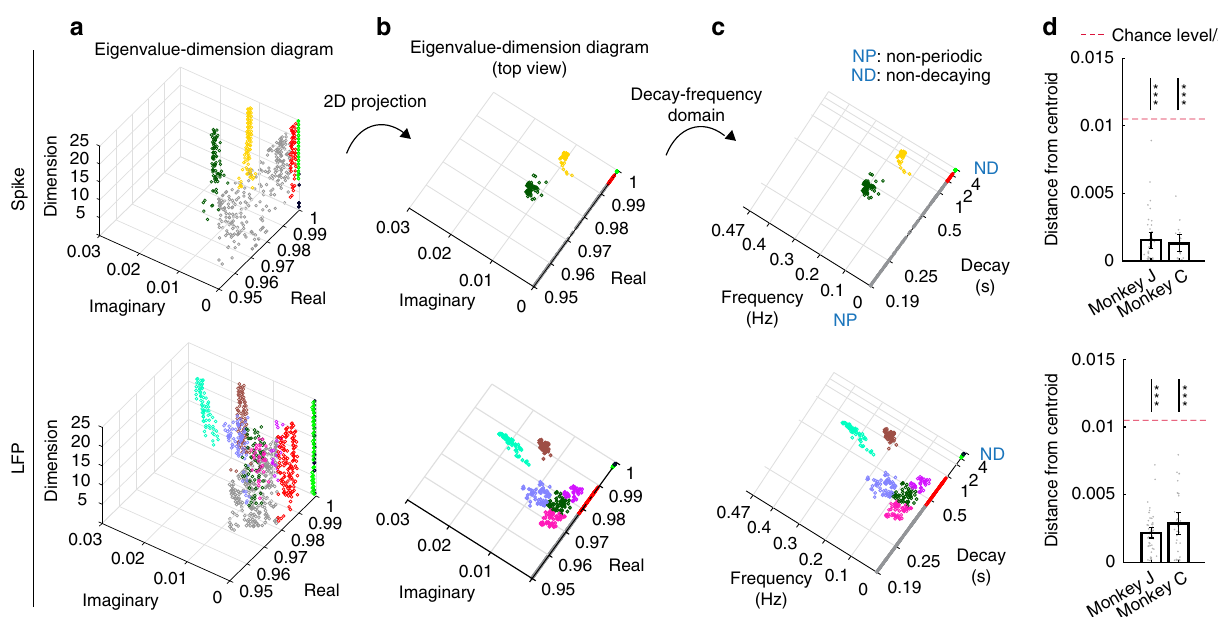
Fig. 3 Both spiking and LFP network activity exhibit several principal modes in their dynamics. a Eigenvalue-dimension diagram for spiking (top) and LFP (bottom) network activity in one sample session. The vertical clusters are principal modes each shown with a different color. Modes that cannot be categorized in clusters are shown in grey. b The top view of eigenvalue-dimension diagram in a . For simplicity, in this view we show the modes for dimensions higher than 10. c The top view of eigenvalue-dimension diagram in ( b ) in the interpretable decay-frequency domain (Methods). NP and ND represent non-periodic or non-decaying dynamics, respectively. d Principal modes that form vertical clusters exist in every session. Each data point (grey dot) represents the mean distance of the members in one vertical mode cluster in one session from its centroid in the x – y plane. Data points are shown for all clusters in all sessions. Bars represent the mean over data points and error bars represent the 95% con fi dence bounds of this mean. A principal mode cluster must have a mean member distance to cluster centroid that is signi fi cantly smaller than half of chance-level distance ( P < 1.6 × 10 − 4 , N s = 39, 17 (top) and N s = 53, 31 (bottom) mode clusters across sessions in Monkey J and C, one-sided Wilcoxon signed-rank test, FDR-corrected) (Methods). Asterisks indicate signi fi cance of this comparison (* P < 0.05, ** P < 0.005, and *** P < 0.0005). Source data are provided as a Source Data fi